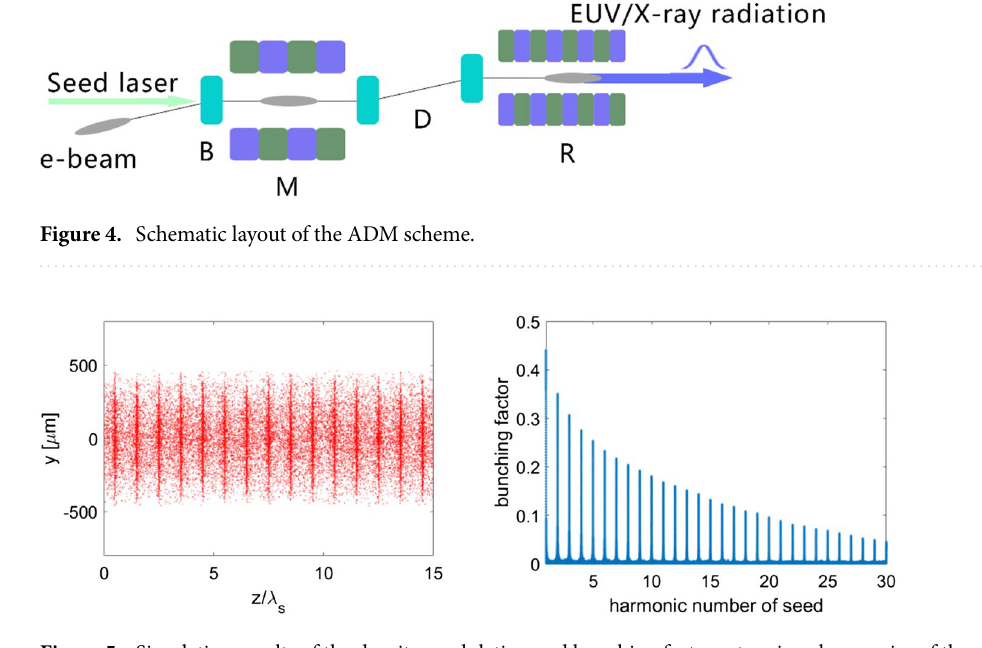
Figure 5. Simulation results of the density modulation and bunching factors at various harmonics of the seed